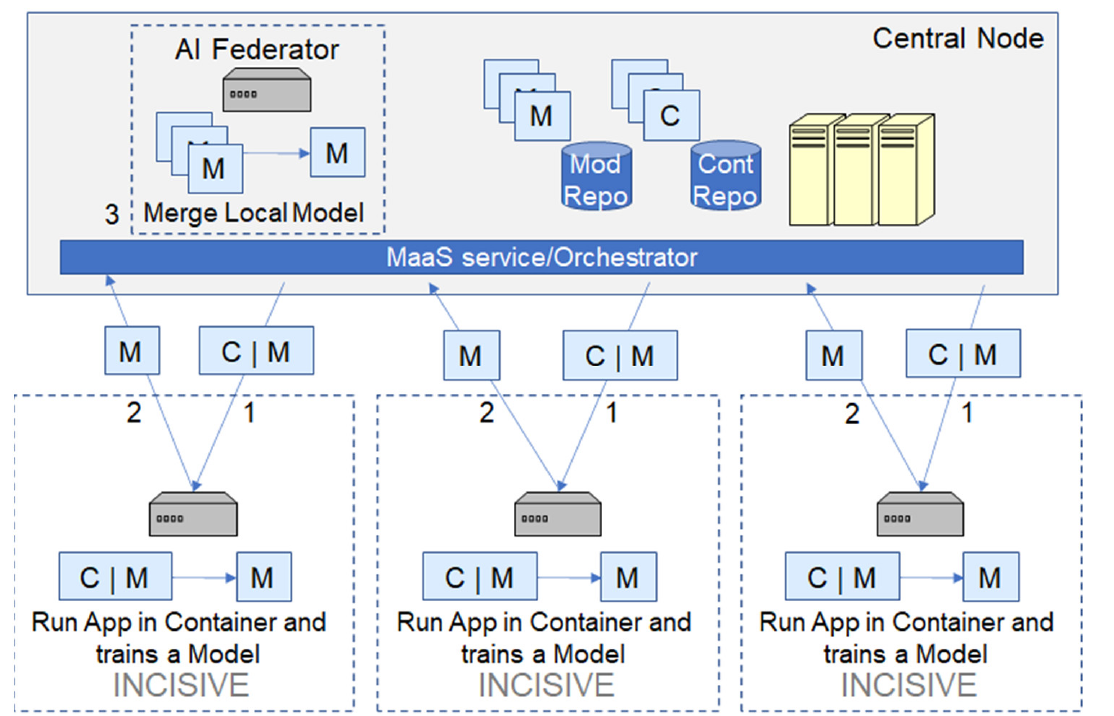
Figure 11. Federated sharing overall process. C stands for containers (required containerized application, e.g., a docker image) and M for models. Notice that the container is only required to be sent once at each federated node. The code hosted in the container is run using the input model and the data is stored in the node, producing a new model as the output.